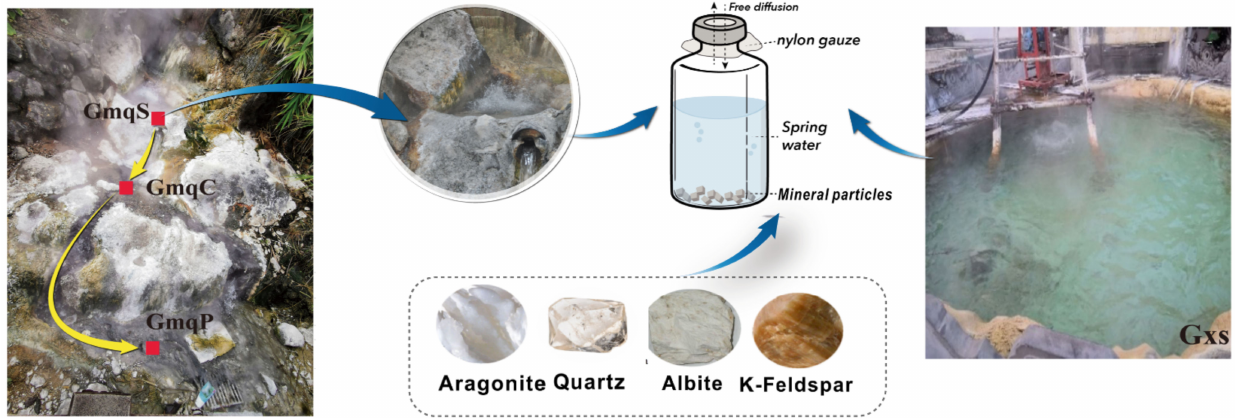
Figure 1. Design of the in-situ cultivation experiment. Four fresh minerals including aragonite, quartz, albite, and K-feldspar were separately filled in serum bottles and cultivated in Gumingquan source (GmqS) and Gongxiaoshe (Gxs) spring. Table 1. The physicochemical parameters and main mineralogical composition in Gumingquan and Gongxiaoshe springs. Spring